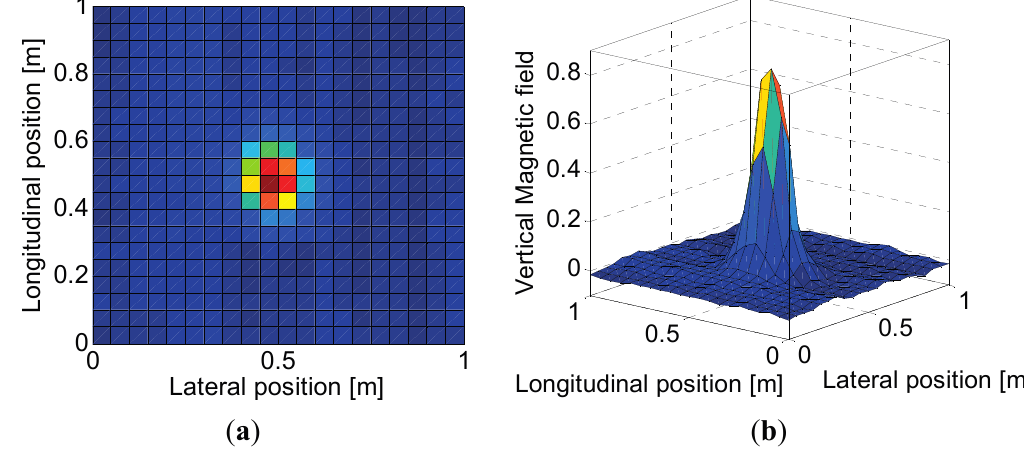
Figure 6. Distribution plot from MFS: ( a ) In 2D; ( b ) In